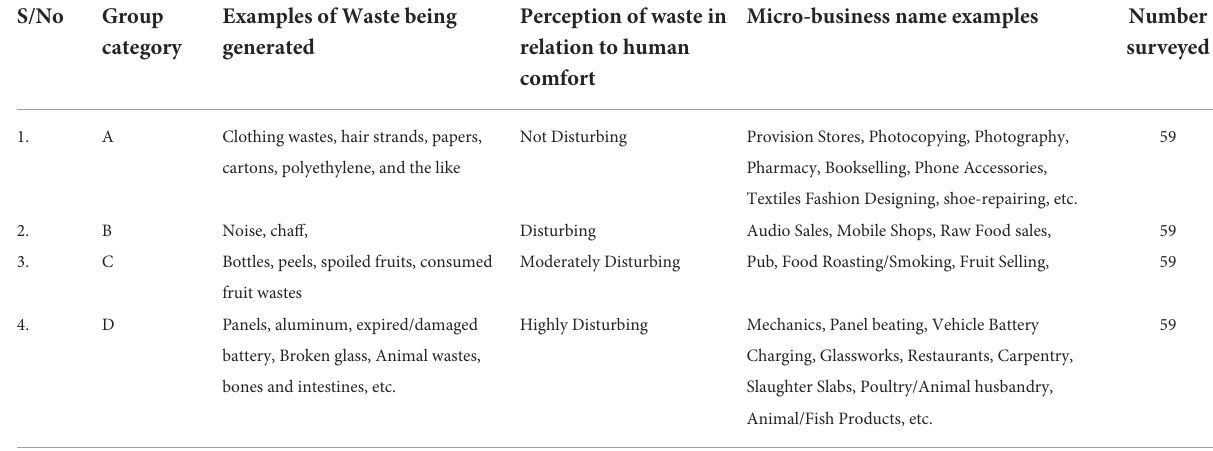
TABLE 1 Grouping and characteristics of the